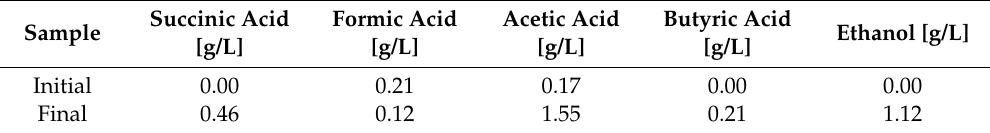
Table 9. Formation of by-products during